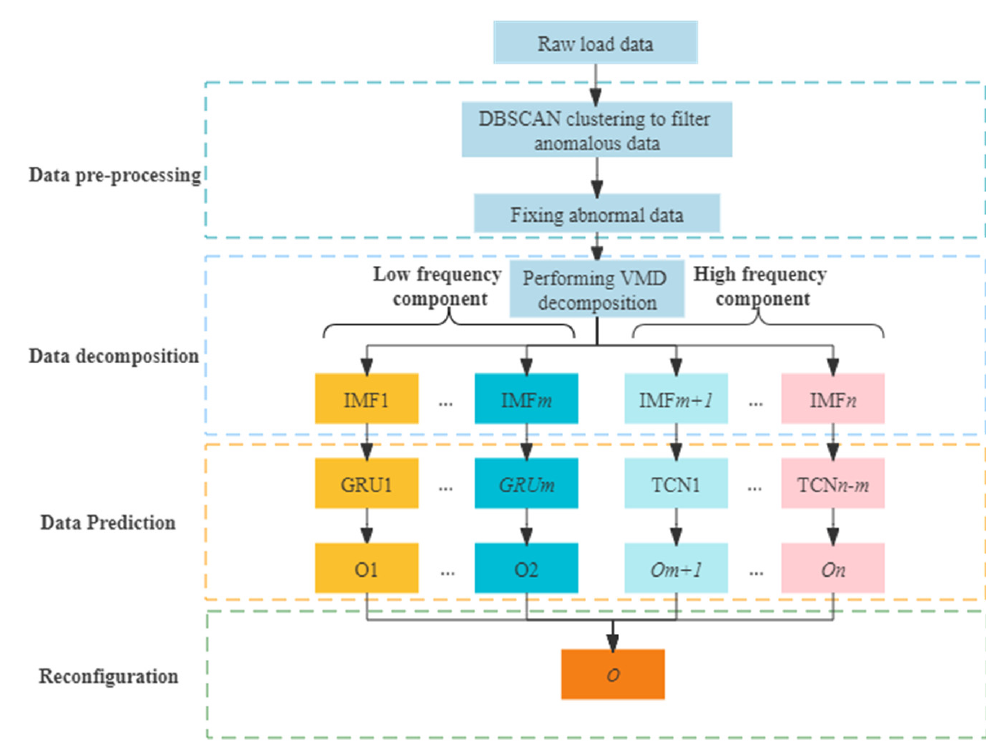
Figure 5. VMD-GRU-TCN based forecasting process.